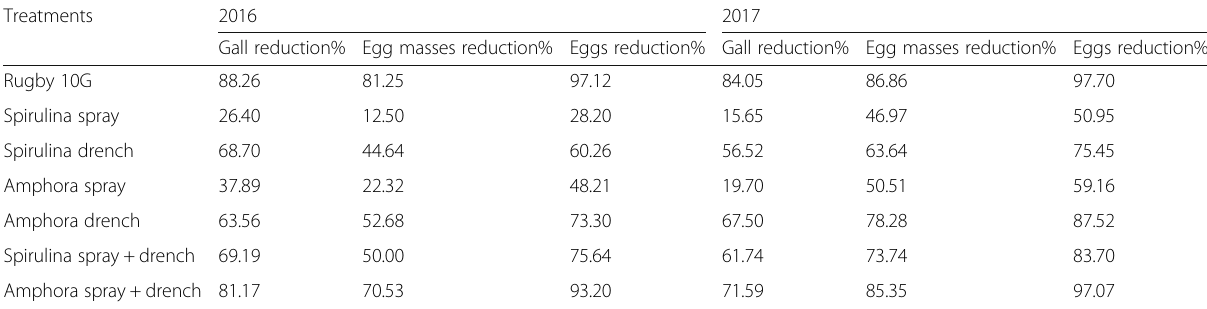
Table 6 Means of galls, egg mass, and egg number reductions compared with control at different treatments in 2016 and 2017 seasons